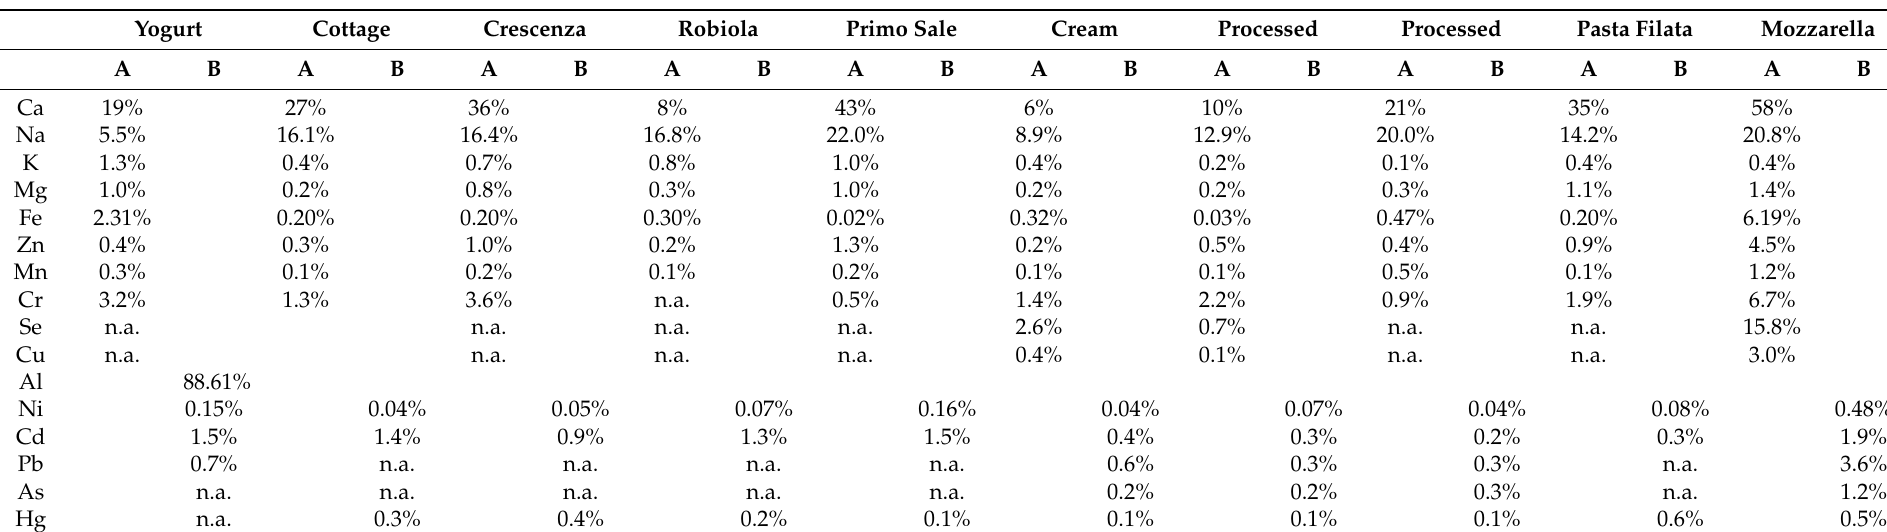
Table 5. Percentage of RDA or IA (A), and of TDI or TWI, or BMDL01 (B) for delactosed cheeses consumption. Yogurt Cottage Cream Processed